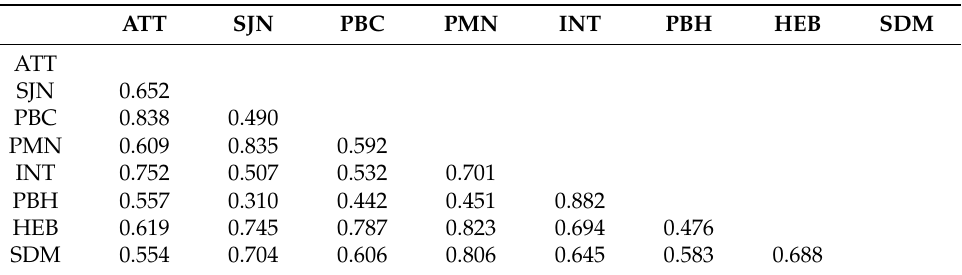
Table 3. Discriminant validity